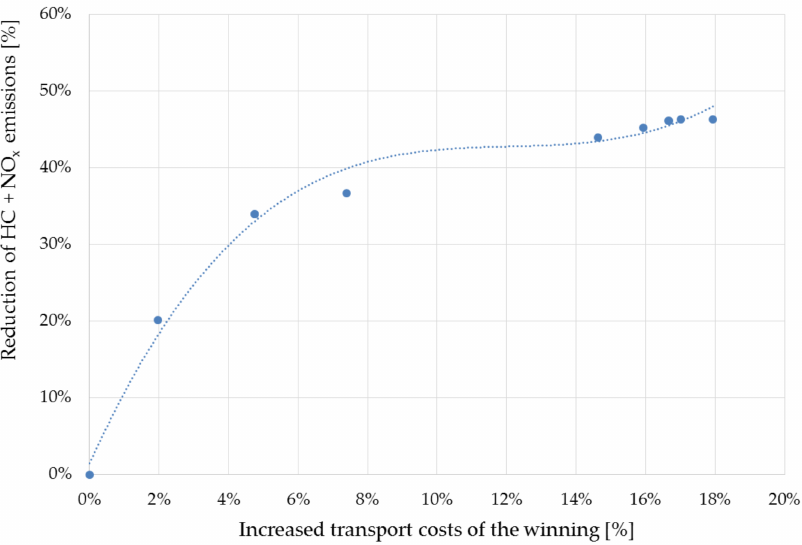
Figure 11. The potential to reduce HC+NO x emissions from the transport costs of the winning, depending on the adopted weights of optimization criteria as a function of the objective.